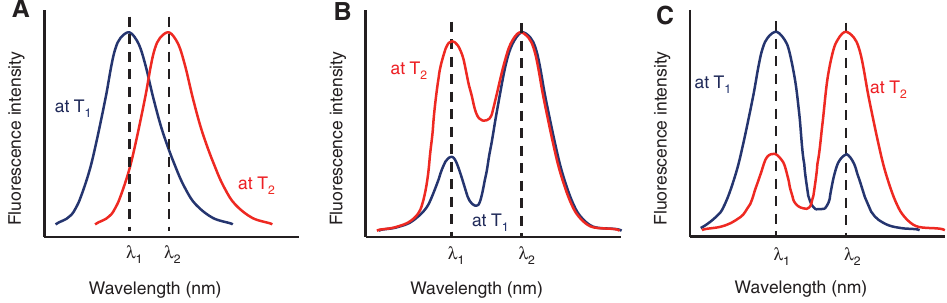
Figure 1: Temperature-dependent emission spectra of ratiometric luminescent molecular thermometers. (A)–(C) represent different types of responses at two temperatures (T